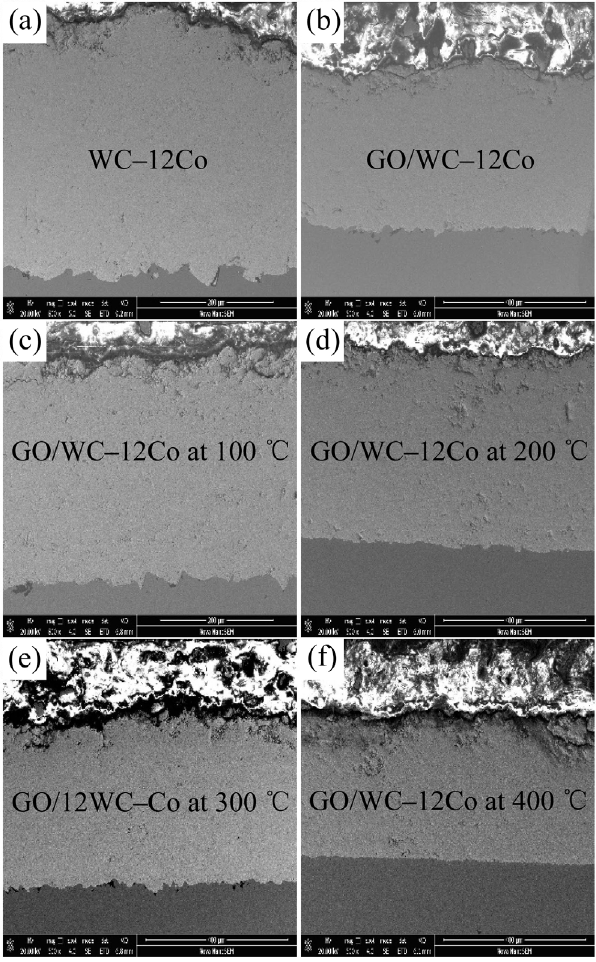
Fig. 6 Cross-sectional morphologies of the coatings obtained after different heat treatment